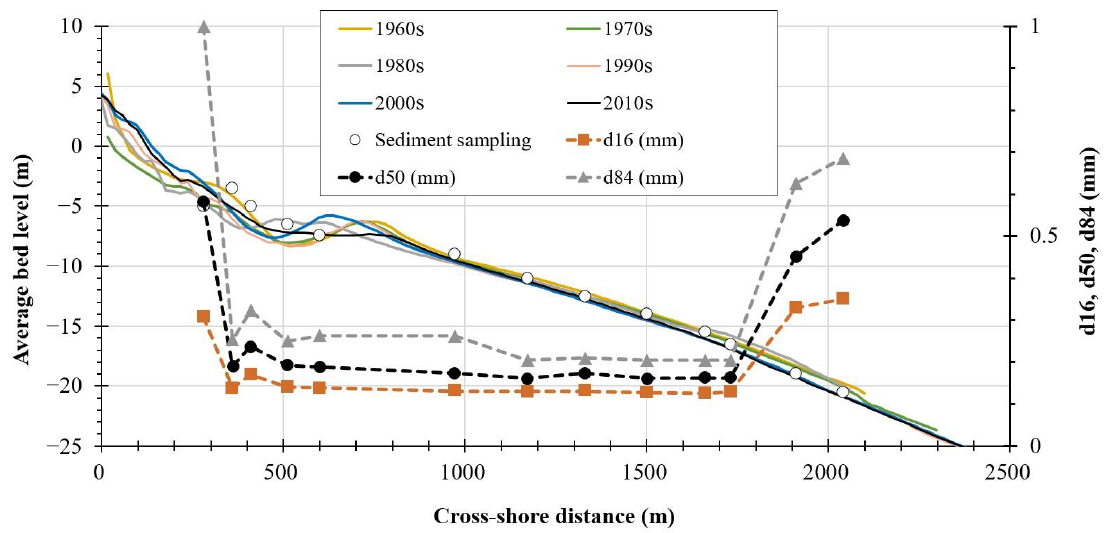
Figure 15. Beach profiles from a reference point of the survey to the cross-shore distance of 2500 m during 1960 – 2017 with the sediment sampling points. The dotted lines show the grain size characteristics of each sampling point including d 16 , d 50 , and d 84.